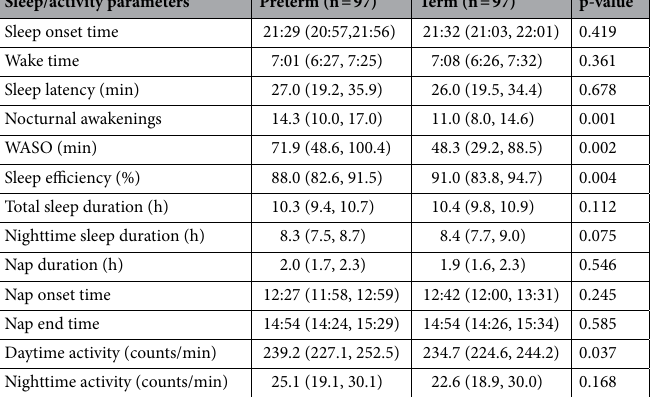
Table 2. Comparison of sleep parameters and daytime activity between preterm and term toddlers (median (IQR)). WASO: wake after sleep onset.